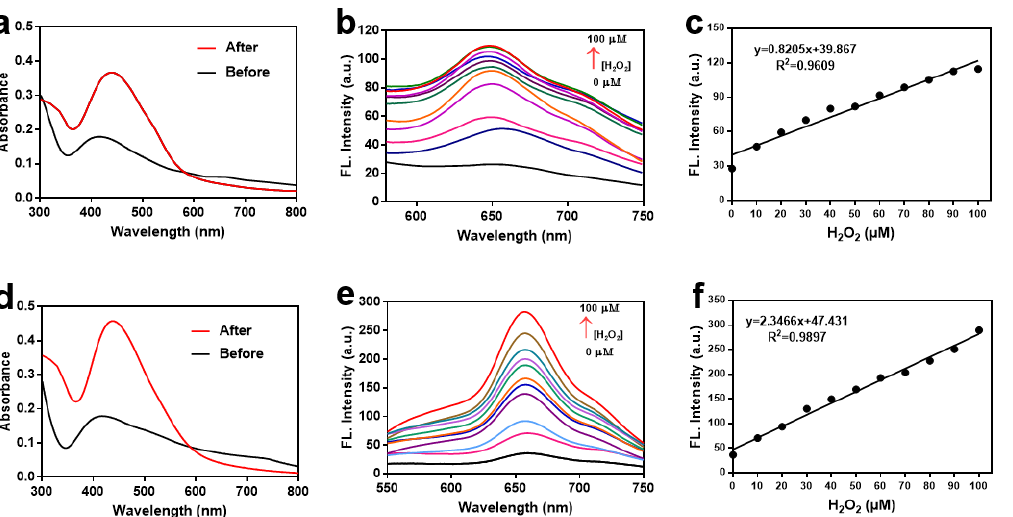
Figure 2. Absorption and fluorescence spectrum. ( a ) Absorption spectrum of P1 (10 μ M) before and after treatment with H 2 O 2 in PBS. ( b ) Fluorescence spectrum of probe P1 in concentration-dependent H 2 O 2 (0–100 μ M). ( c ) Linear relation spectrum of P1 between fluorescence intensity and H 2 O 2 concentration. ( d ) Absorption spectrum of P2 (10 µ M) before and after treatment with H 2 O 2 in PBS. ( e ) Fluorescence spectrum of probe P2 in concentration-dependent H 2 O 2 (0–100 µ M). ( f ) Linear relation spectrum of P2 between fluorescence intensity and H 2 O 2 concentration. Incubation time: 10 min.